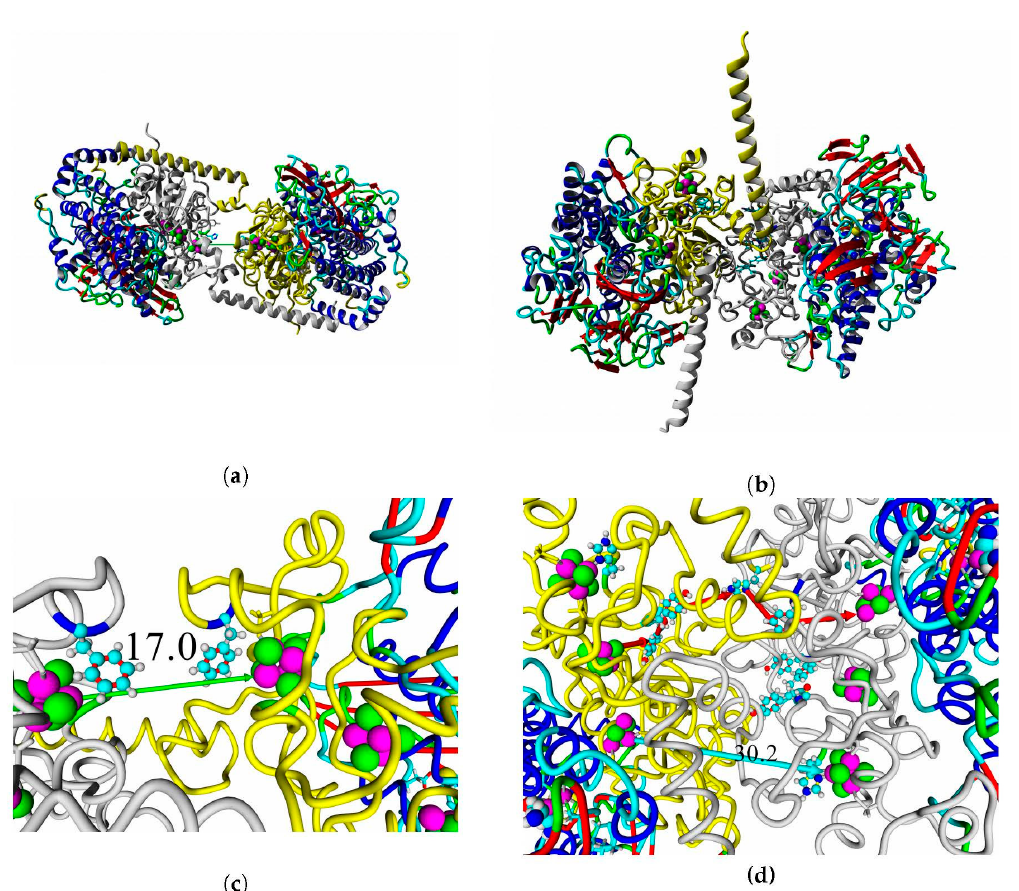
Figure 13. FeS cluster interaction in HupSL–HupSL hydrogenase oligomers obtained by protein–protein docking. Overall view of the oligomers: ( a ) HupSL from Rba. capsulatus ; ( b ) HupSL from Rba. sphaeroides . The small subunits are colored gray and yellow. Close view of FeS clusters in the adjacent small subunits: ( c ) HupSL from Rba. capsulatus ; ( d ) HupSL from Rba. sphaeroides. Aromatic residues are shown as balls and sticks colored by element. Green and cyan arrows illustrate the shortest paths of direct electron transfer (distance shown in Å); red arrows ( d ) show possible direction of electron “hopping” through the network of aromatic residues.